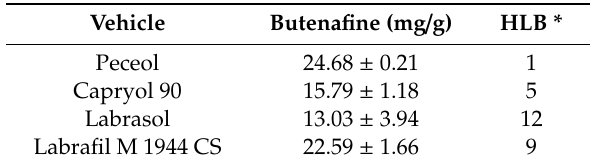
Table 1. Solubility of butenafine in various vehicles at 25 ◦ C ( n =